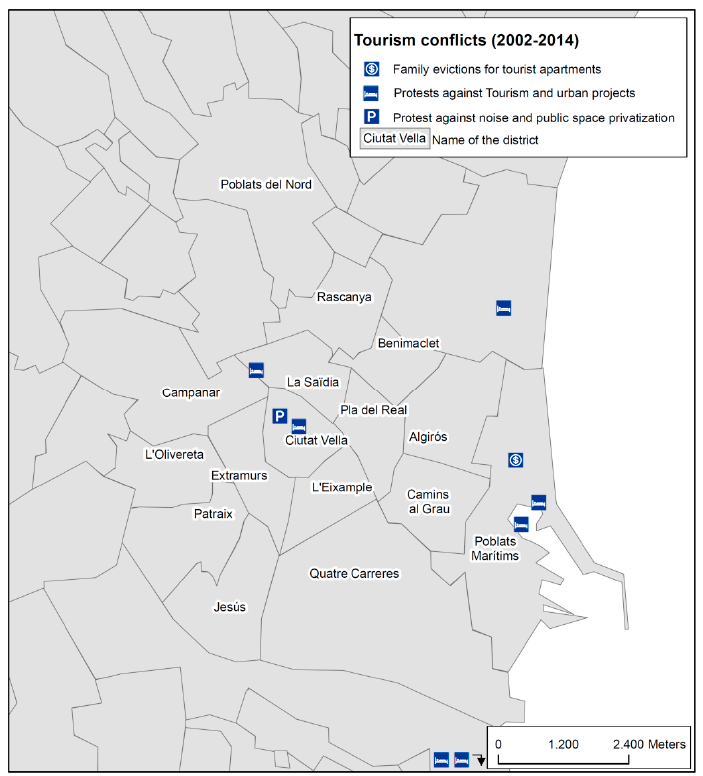
Figure 7. Tourism conflicts, 2002–2014. Source: [28].